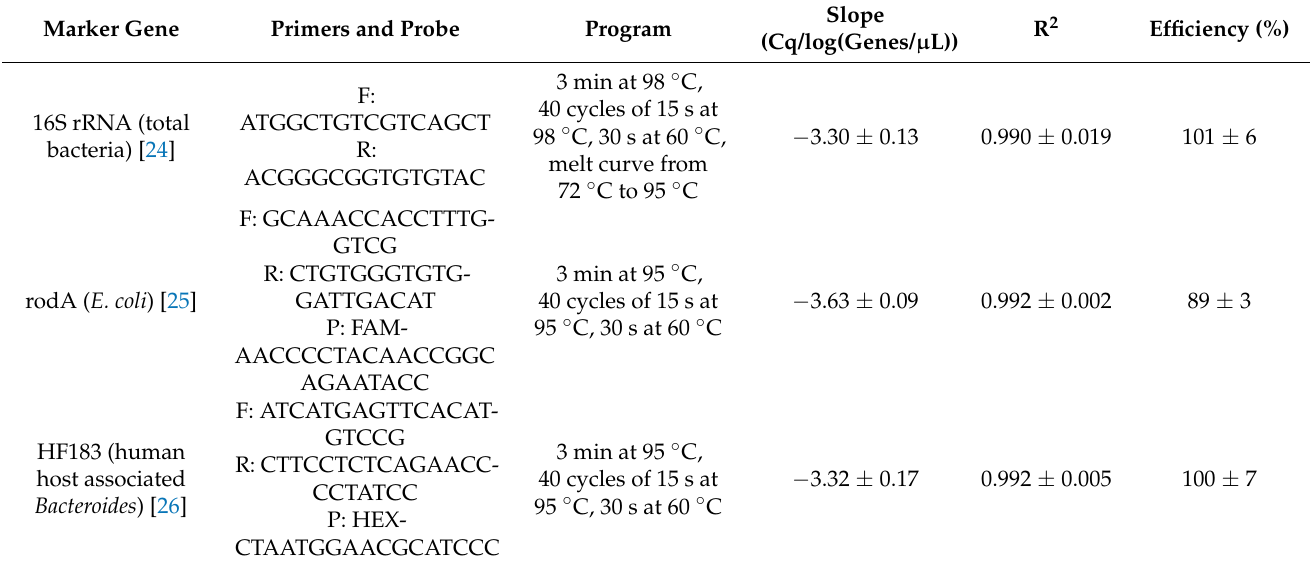
Table 2. Primers and probes with literature references, sequence, temperature cycling program, and metrics of the calibration curves on the portable qPCR